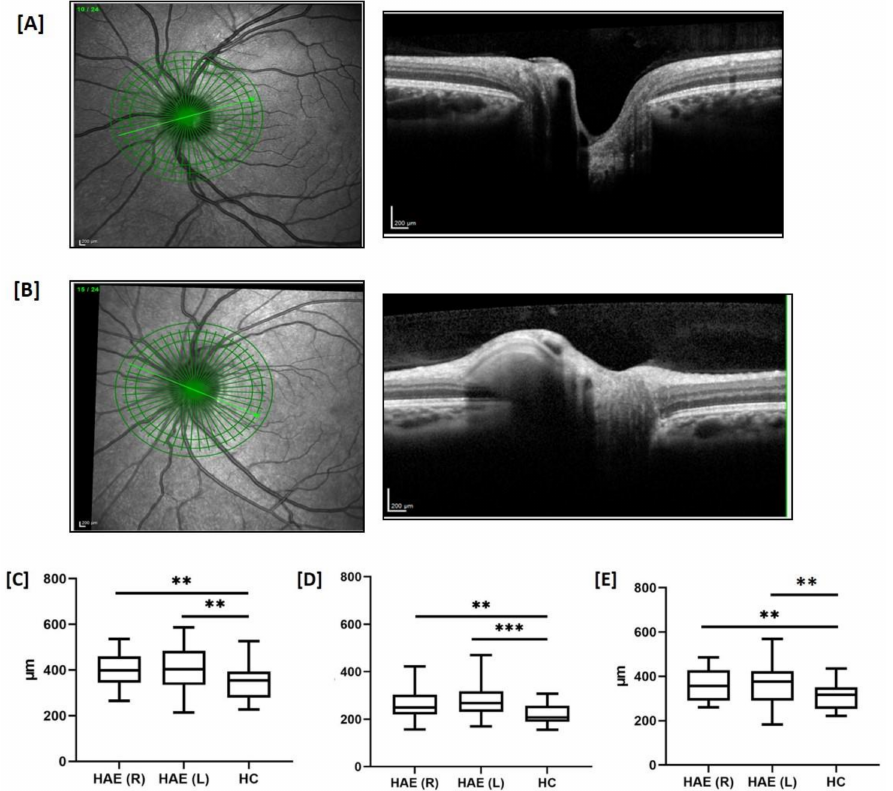
Figure 3. Optical coherence tomography (OCT)-derived cross-sectional images of the optic nerve head. Representative scans of the optic nerve head (ONH) from the left eye of a healthy control (HC) and a patient with hereditary angioedema (HAE) are depicted in ( A , B ), respectively. The left image shows the fundus image, which is acquired simultaneously to the optical coherence tomography (OCT) image. The right image is the respective cross-sectional OCT scan as a grayscale image. The green line indicates the location of the cross-section. ONH swelling occurred in the patient with HAE ( B ). ONH from patients with HAE was thicker than ONH from HC in nasal ( C ), temporal ( D ), and global ( E ) scans. R, right eyes; L, left eyes. The ONH thickness was compared between HAE and HC using the parametric unpaired T test or the nonparametric Mann-Whitney U test when appropriate. p < 0.05 were considered significant, ** p < 0.01. *** p <